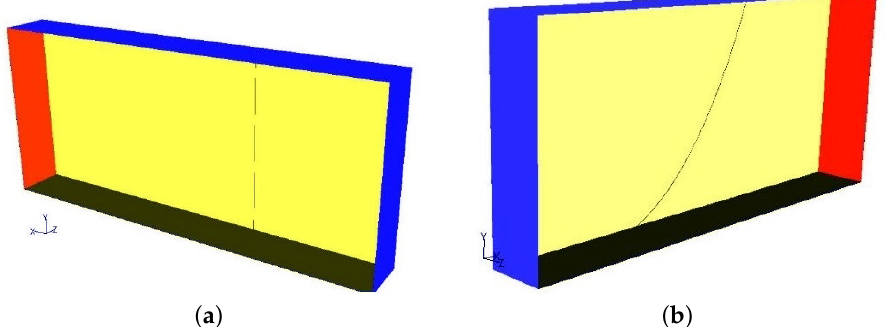
Figure 1. The calculation model diagrams of ( a ) TTR and ( b ) SCR. ( a ) TTR calculation model; ( b ) SCR calculation